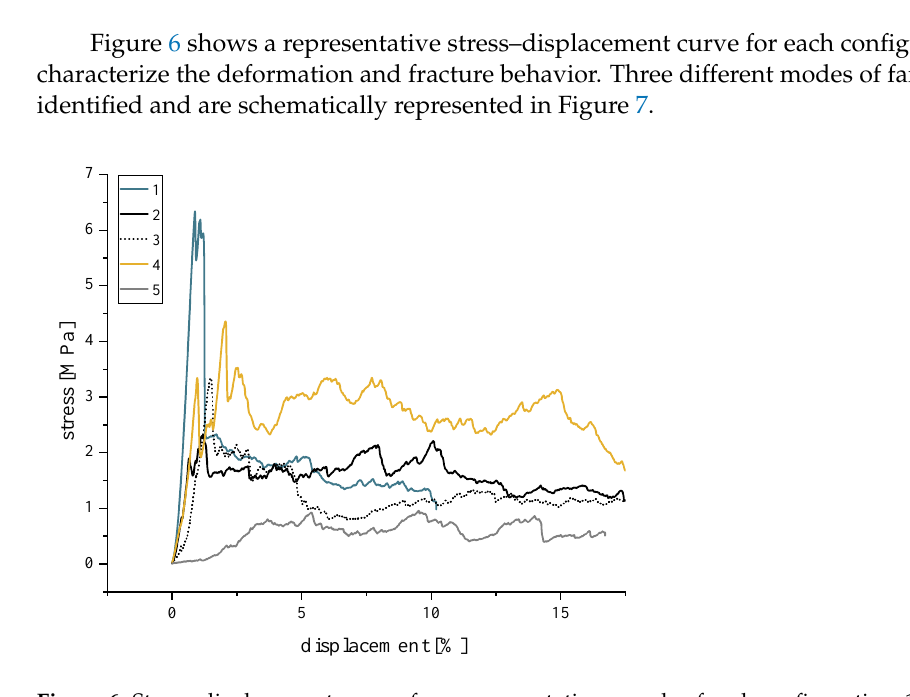
Figure 6. Stress–displacement curves for a representative sample of each configuration, 1–5.